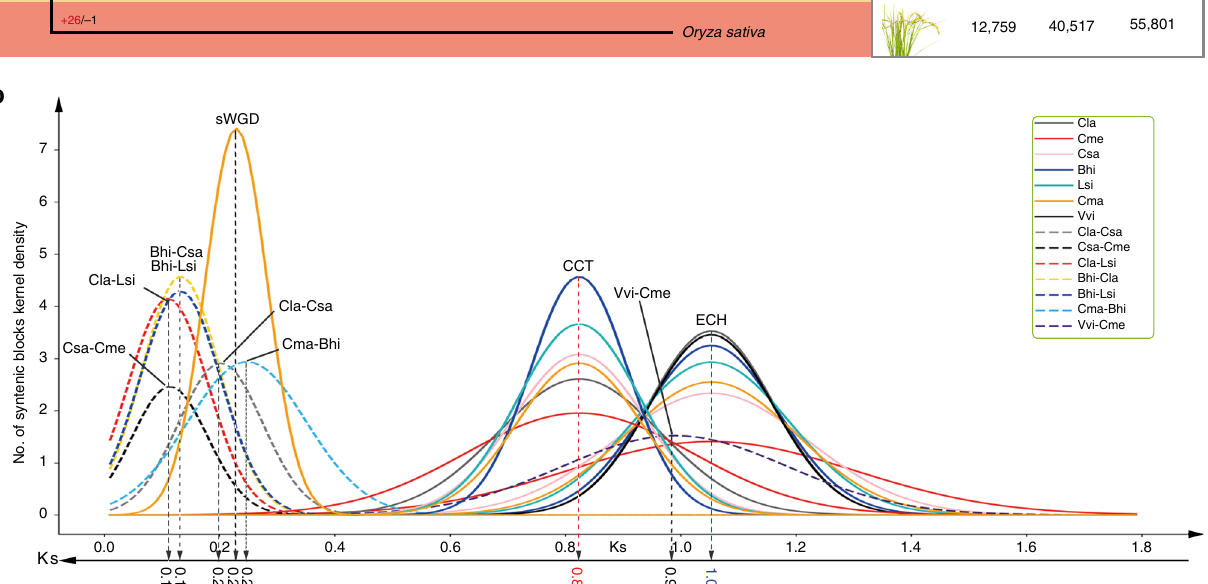
Fig. 1 Phylogenetic relationship and comparative genomics analyses. a Phylogenetic tree of 12 plant species and evolution of gene families. Blue numerical value beside each node shows the estimated divergence time of each node (MYA, million years ago). Gene family: numbers of gene families in each species; gene in family: the numbers of genes that could be clustered into gene families; total gene: the total gene numbers for each species. b Distribution of synonymous substitution levels (Ks) of syntenic orthologous (solid curves) and paralogous genes (dashed curves) after evolutionary rate correction. Bhi: Benincasa hispida ; Cma: Cucurbit maxima ; Cme: Cucumis melo ; Lsi: Lagenaria siceraria ; Cla: Citrullus lanatus ; Csa: Cucumis sativus ; Vvi: Vitis vinifera . The source data underlying a is provided as a Source Data fi le